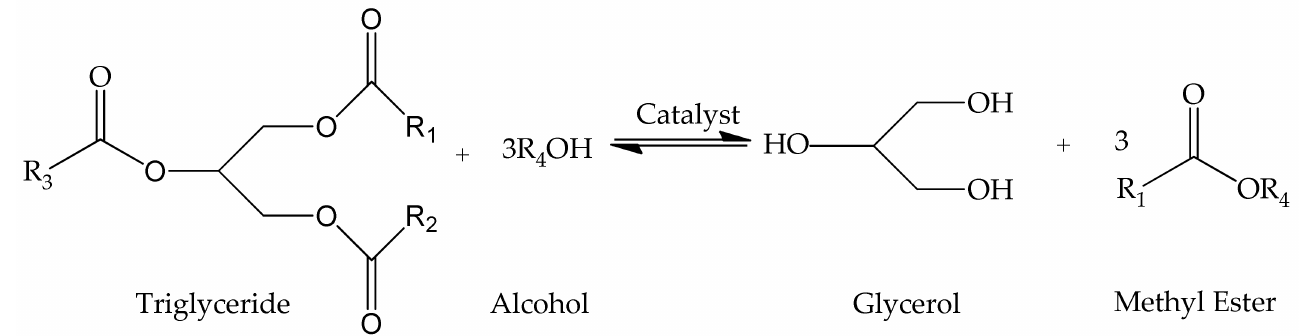
Figure 1. Overall triglyceride transesterification reaction for BD production [36] “Used with permis- sion of [Royal Society of Chemistry], from [36]; permission conveyed through Copyright Clearance Center,